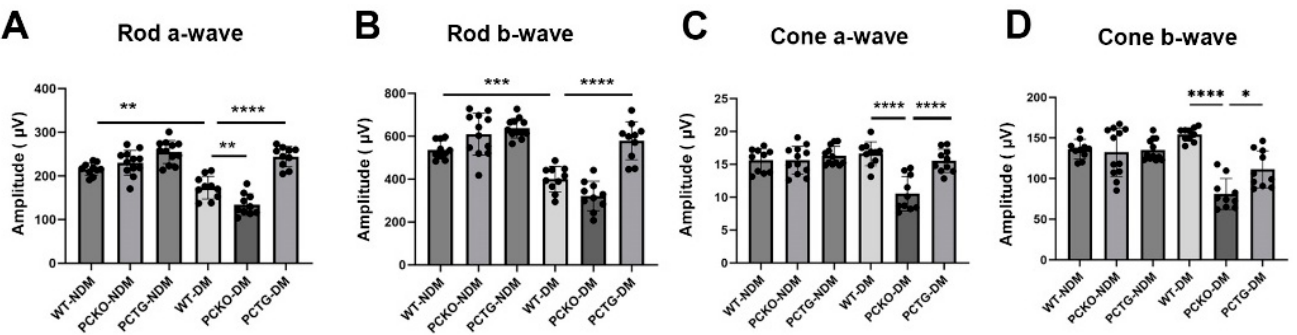
Figure 4. Impaired retinal function in diabetic PCKO mice. A-wave ( A , C ) and b-wave ( B , D ) ampli- tudes of scotopic ERG (Rod, ( A , B )) and photopic ERG (Cone, ( C , D )) were recorded in diabetic mice and age-matched non-diabetic controls at 6 months after diabetes onset. n = 10–12. Data are pre-